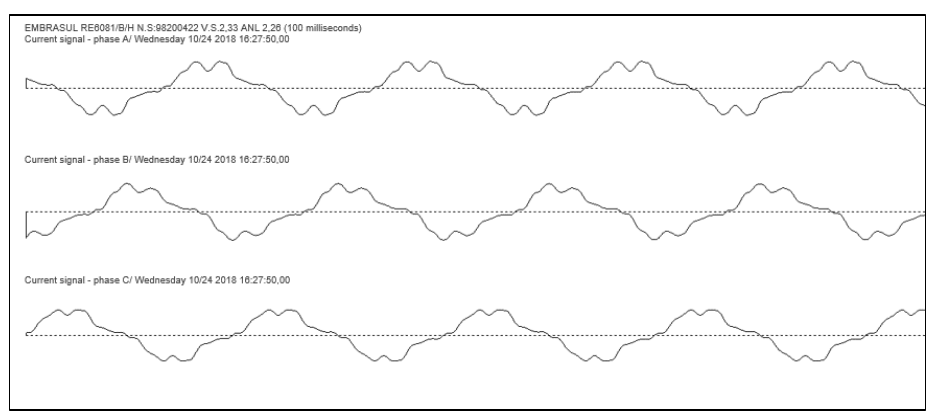
Figure 5: Current output from UPS A.